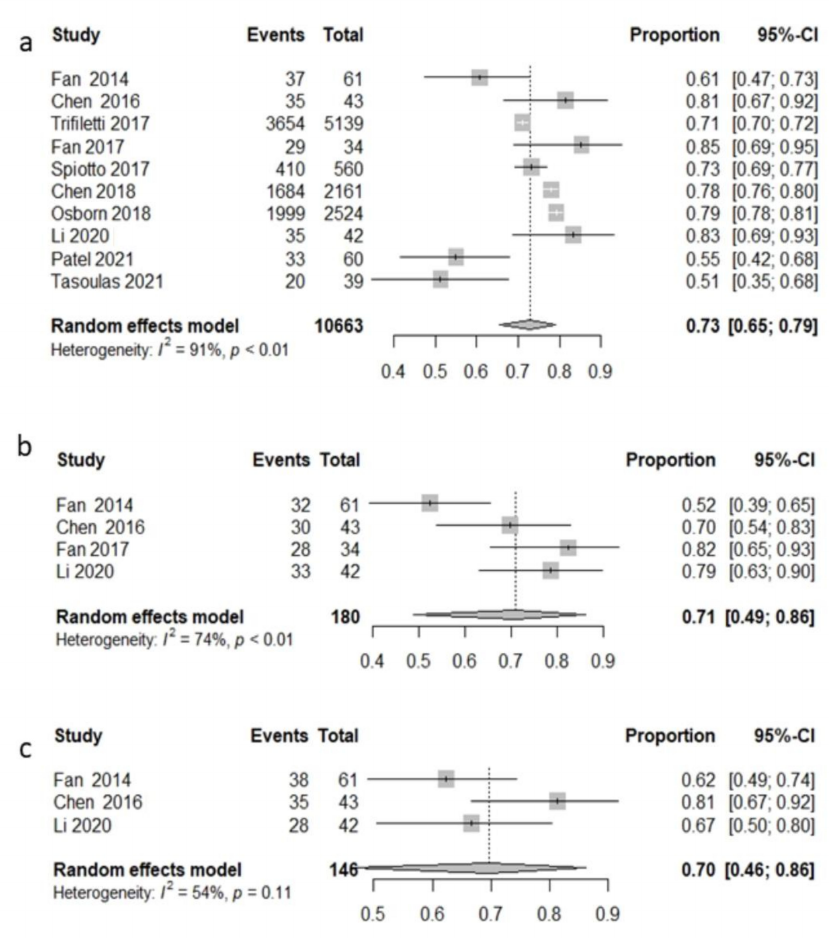
Figure 4. Forest plot, 3-year survival analysis, chemoradiotherapy population: overall survival